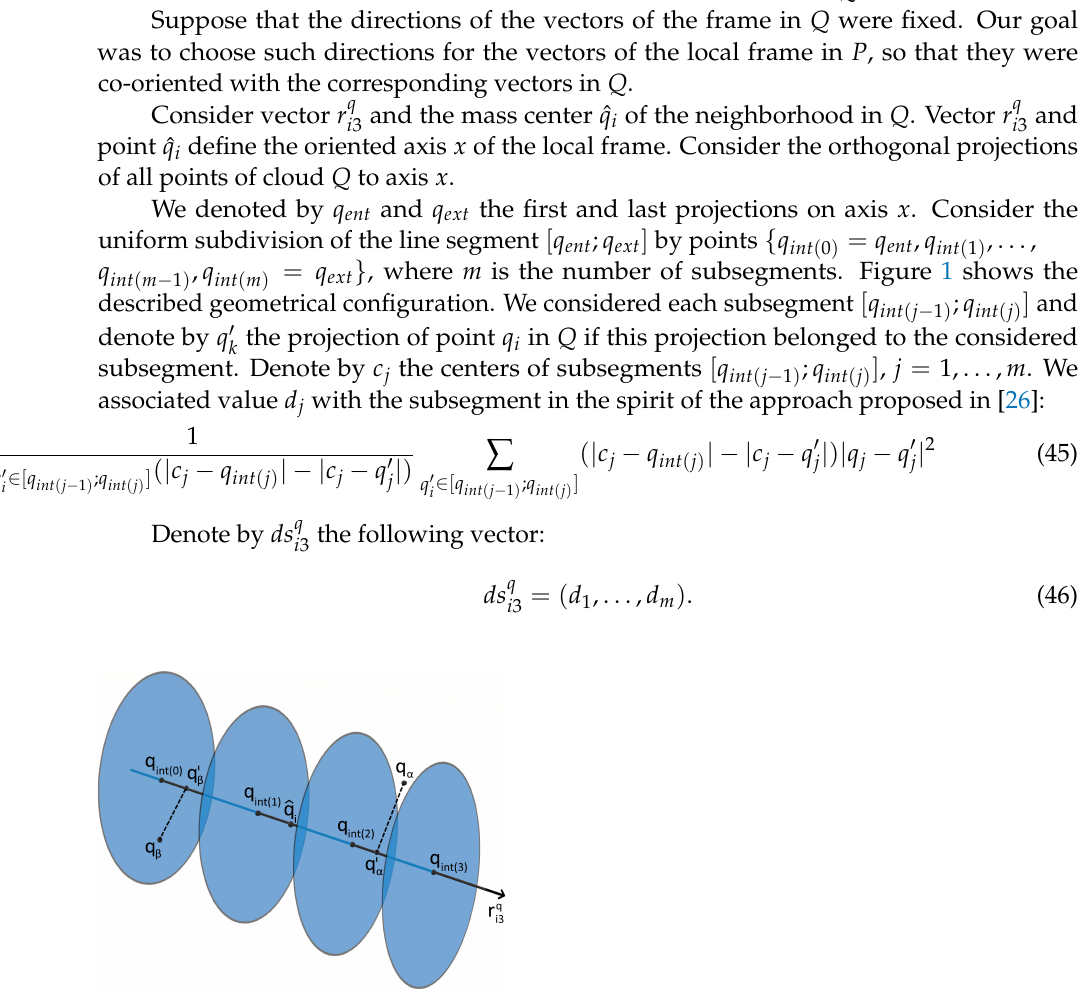
Figure 1. Orthogonal projections of the points of cloud Q onto the axis defined by point ˆ q i and vector r q i 3